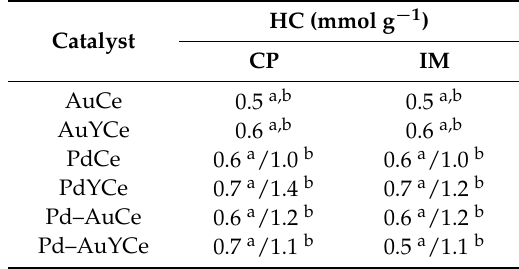
Table 2. Experimental hydrogen consumption (HC) during TPR of the studied